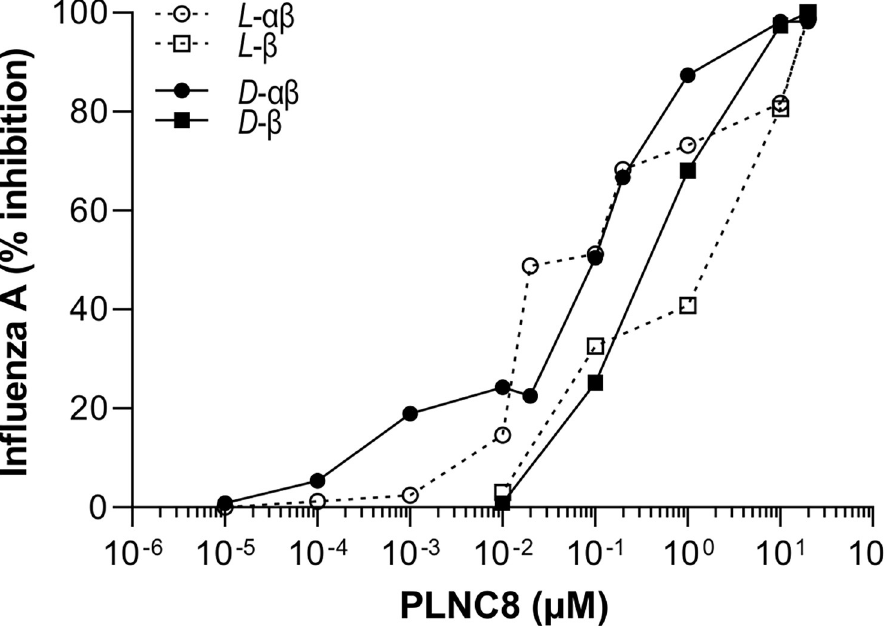
Fig 8. Antiviral activity of PLNC8 αβ against IAV. IAV (1000 PFU/ml) was pre-treated with the L-enantiomer or D- enantiomer of PLNC8 β or PLNC8 αβ (1:1) for 1 h at 37˚C. The suspensions were transferred to MDCK cells followed by quantification of the viral load. A final concentration of > 0.1 μ M of PLNC8 αβ was required to drastically reduce the amount of influenza A. The data (n = 2) are presented as mean.